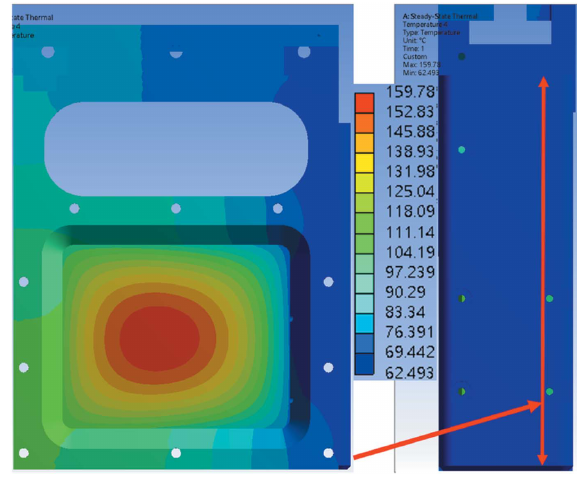
Figure 13 Numerical simulation results for temperature distribution of the foil carrier and copper contact pad with a contact area of 60%.